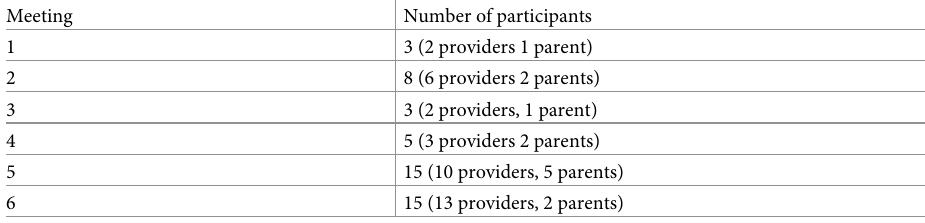
Table 2. Attendee numbers for stakeholder